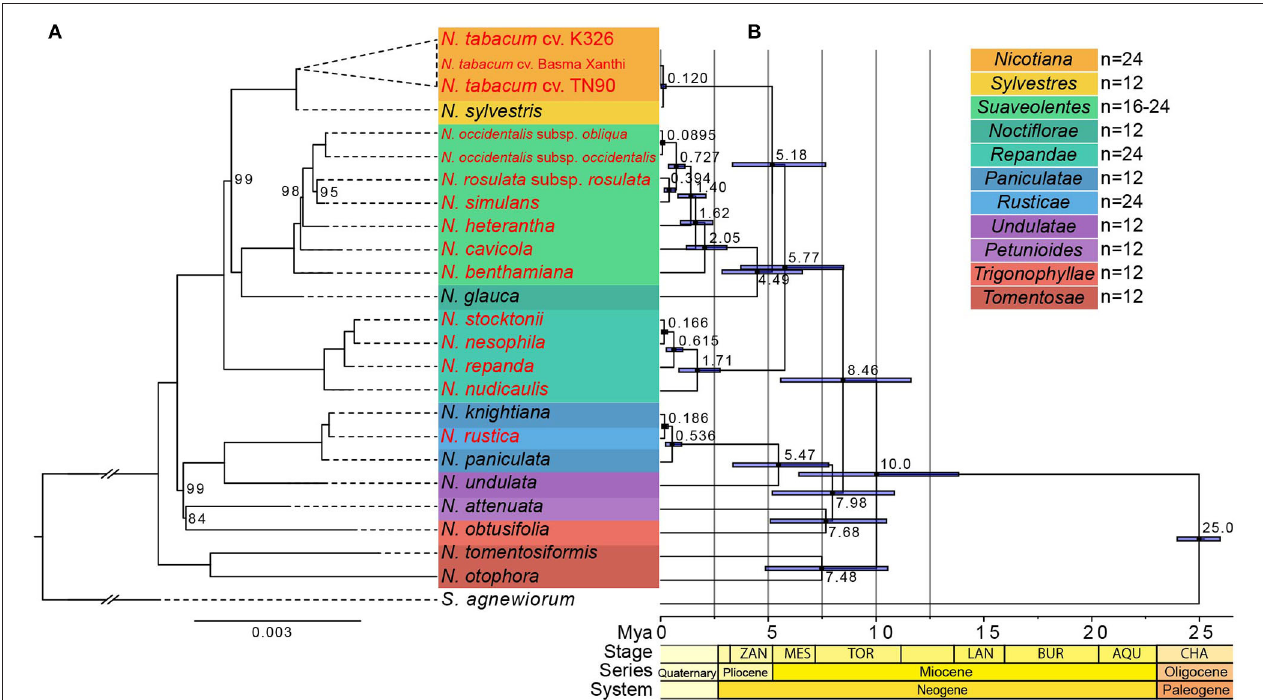
FIGURE 4 | Phylogenetic relationship and divergent time estimate. (A) Phylogeny of Nicotiana species inferred from maximum likelihood analysis of combined 78 protein-coding sequences. Bootstrap support values < 100% were shown above branches. Sections of the genus Nicotiana are shown on the right-hand side, corresponding to the shaded boxes. The allotetraploid species were indicated by red fonts. Scale indicated the base substitution per site. The Nicotiana sections according to Knapp et al. (2004). (B) Divergent time estimate of the 24 Nicotiana taxa and one outgroup species based on 78 protein-coding genes. The branch length of the cladogram reflected the divergent time, and the number beside the node denoted the node age, with the purple bar as 95% highest probability density